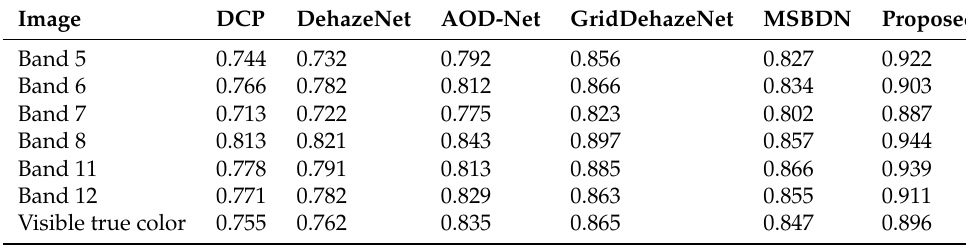
Table 4. Experimental results on different bands: